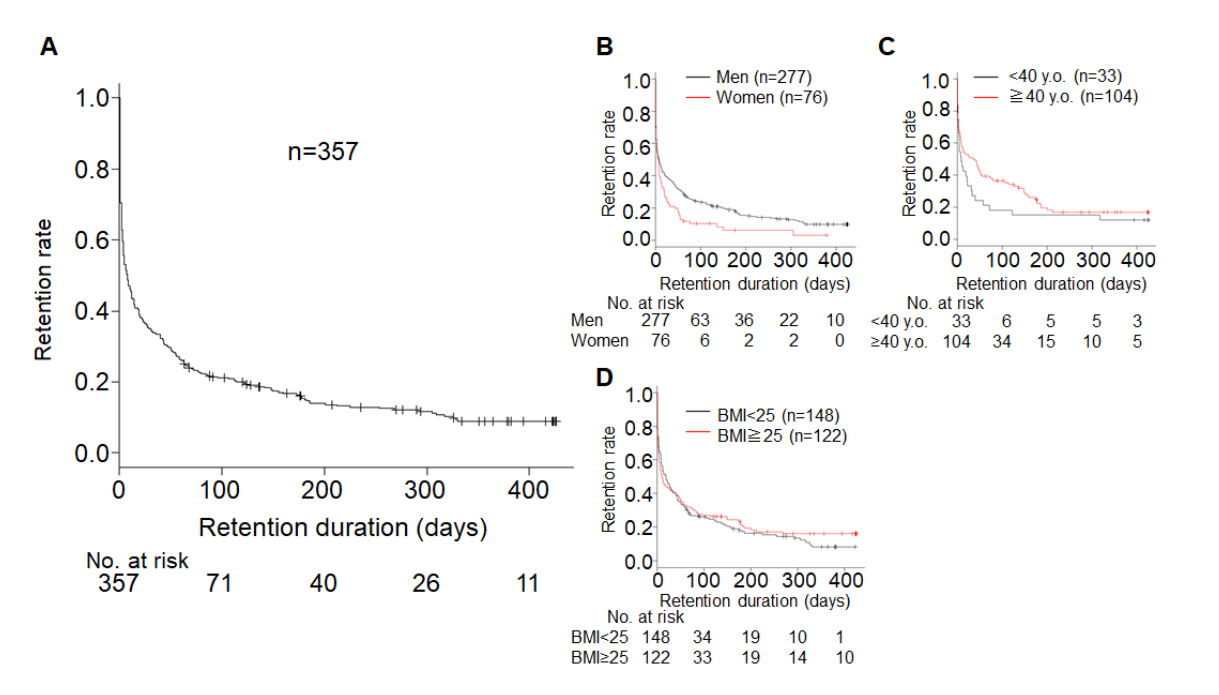
Figure 5. Retention rate of GlucoNote. Retention duration was defined as duration from the day of study enrollment to the last day on the app. (A) Retention rate of overall participants and according to (B) sex (men vs women, P =.01), (C) age at diagnosis (<40 vs ≥ 40 years old [y.o], P =.13), and